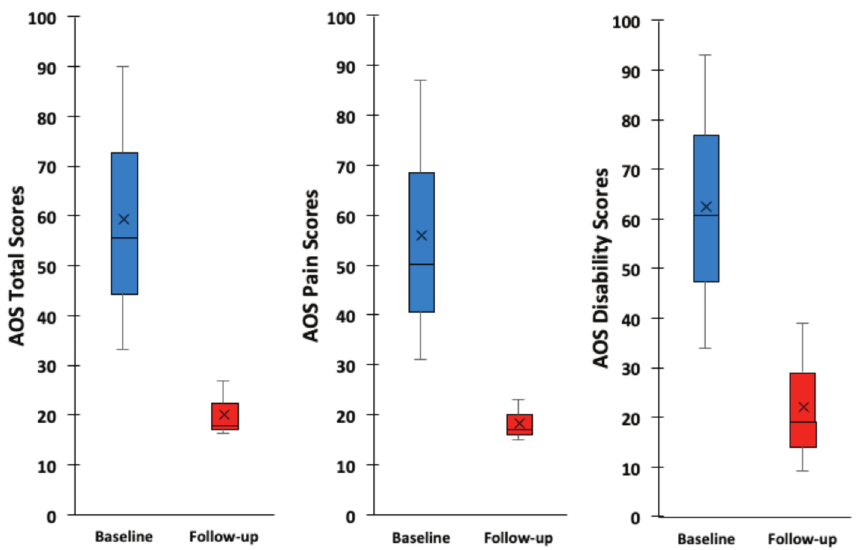
Box plot showing clinical outcome measure scores, preoperatively and at the time of the latest follow-up for the three cases, Fig. 3: with a minimum two years follow-up. The top and bottom of the box represent the interquartile range, the line within the box represents the median, the ‘x’ within the box represents the mean and the whiskers indicate the range. AOS scores show greater pain and disability when the number is higher. Improvement of pain and disability is indicated by lower numbers